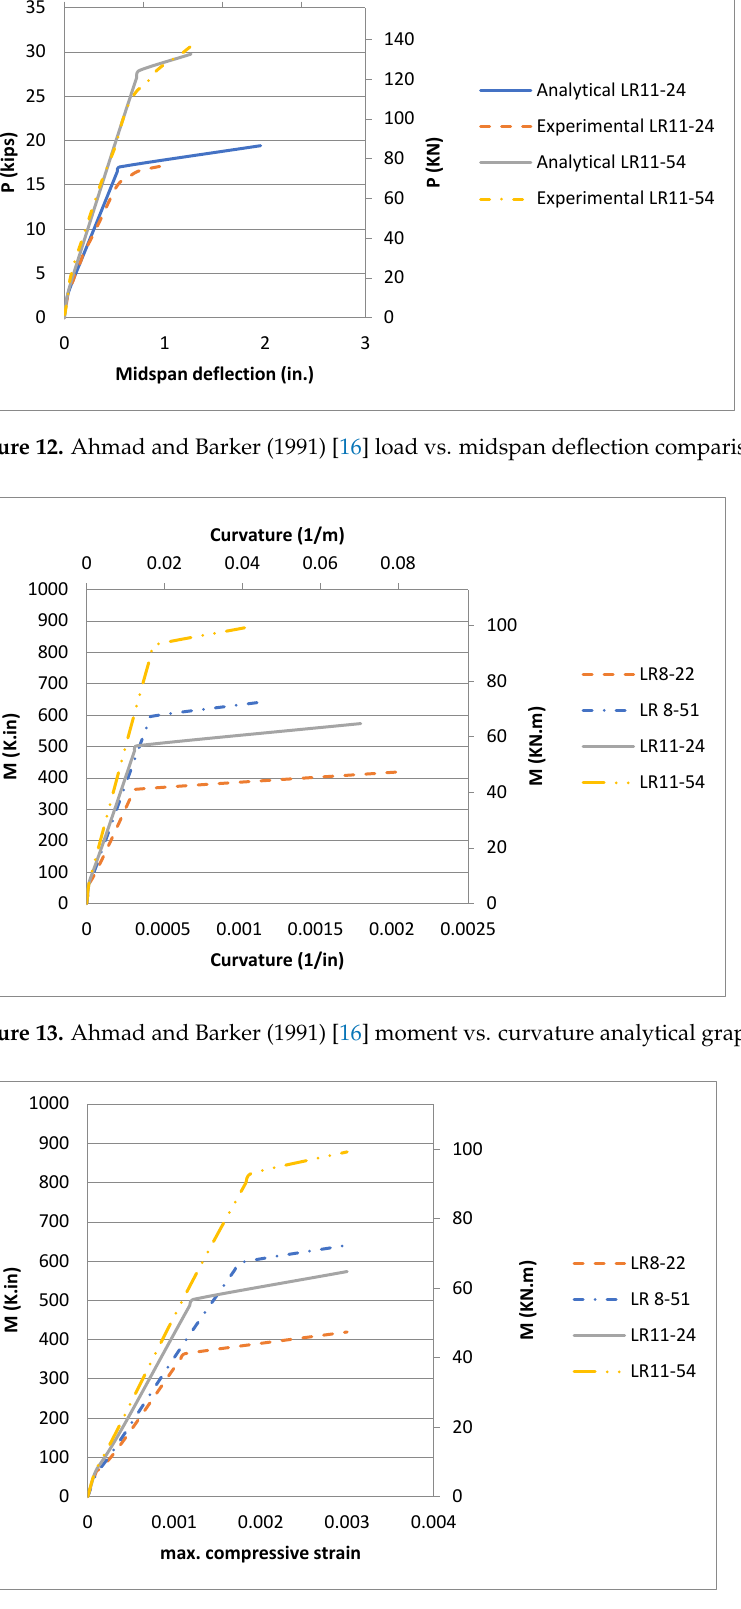
Figure 14. Ahmad and Barker (1991) [16] moment vs. maximum compressive strain analytical graphs. The last three analyzed beams were tested by Ahmad and Batts (1991) [17]. All three beams have the same cross section of 152.4 mm × 304.8 mm (6 in × 12 in) and the same clear span of 3.45 m (136 in). The tested beams were doubly reinforced—see Table 3. Light weight high strength concrete was used for all three beams. Excellent matches were ob- tained against the experimental results for all stages of loading, see Figure 15. LJ11-22 showed a sudden change of stiffness in the post-cracking zone which generally indicates the development of shear cracks. For all three beams the trilinear behavior for the pre- cracking, post-cracking and post-yielding zones was fully confirmed for the moment–cur- vature and moment–maximum compressive strain responses, see Figures 16 and 17. Figure 15. Ahmad and Batts (1991) [17] load vs. midspan deflection comparisons.